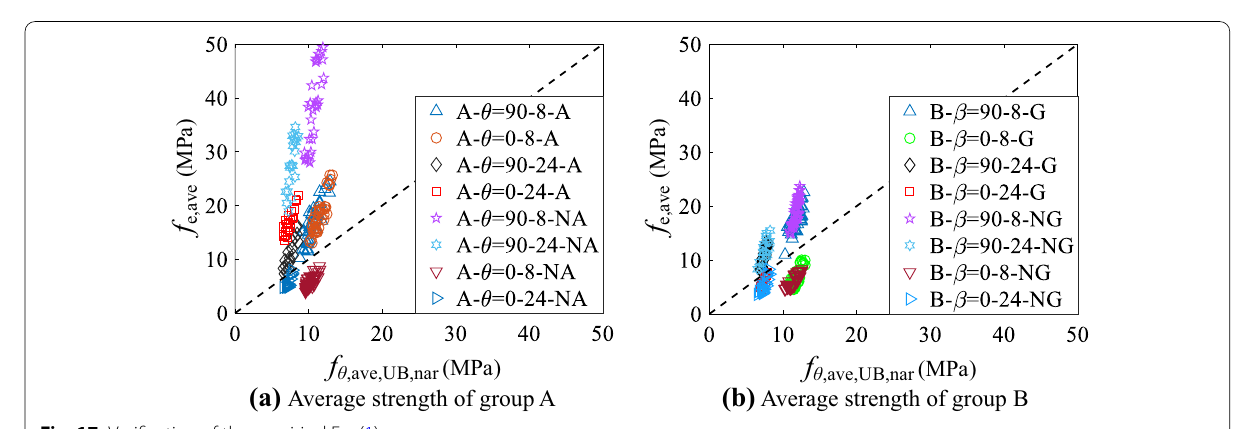
experimental embedment strength f e,ave from the refer- ences and the embedment strength f θ, ave,Mod,nar predicted based on Eqs. (6)–(8) are listed in Table 5. It is illustrated that the predictive embedment strength is similar to the experimental embedment strength. It indicates that the